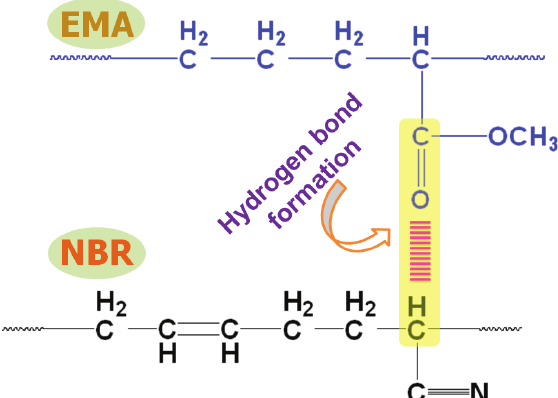
Figure 3: DSC profile: (a) DSC second heating curves and (b) DSC cooling curves. Figure 2: Plausible hydrogen bond formation between carbonyl Figure 2: Plausible hydrogen bond formation between carbonyl group of EMA and CH group of EMA and CH group of NBR. group of NBR.